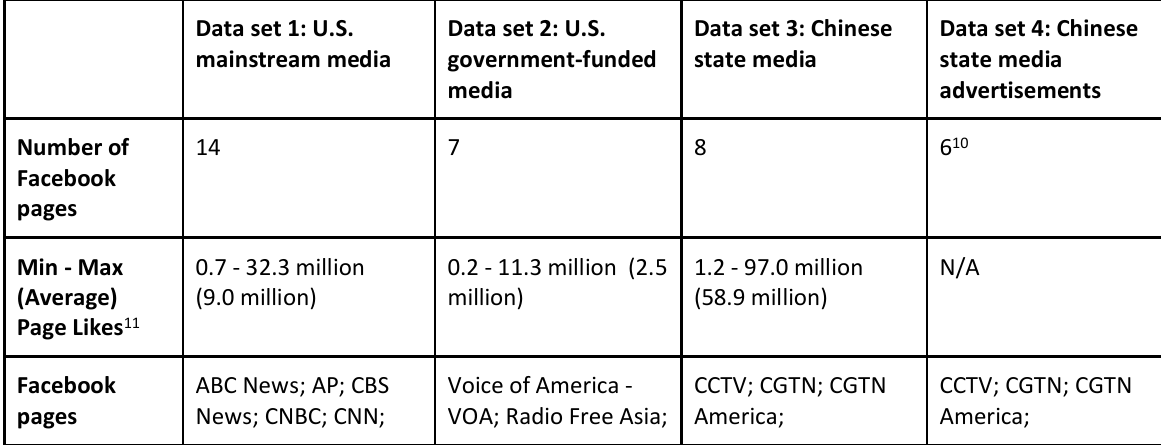
Table 1. Description of four data sets used for analysis Data set 1: